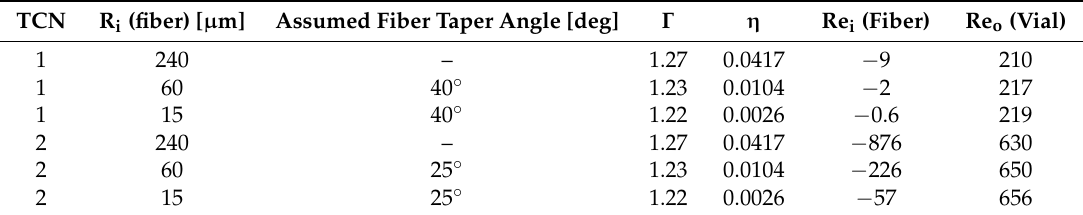
Table 3. Comparison of the non-dimensional parameters for intact and etched